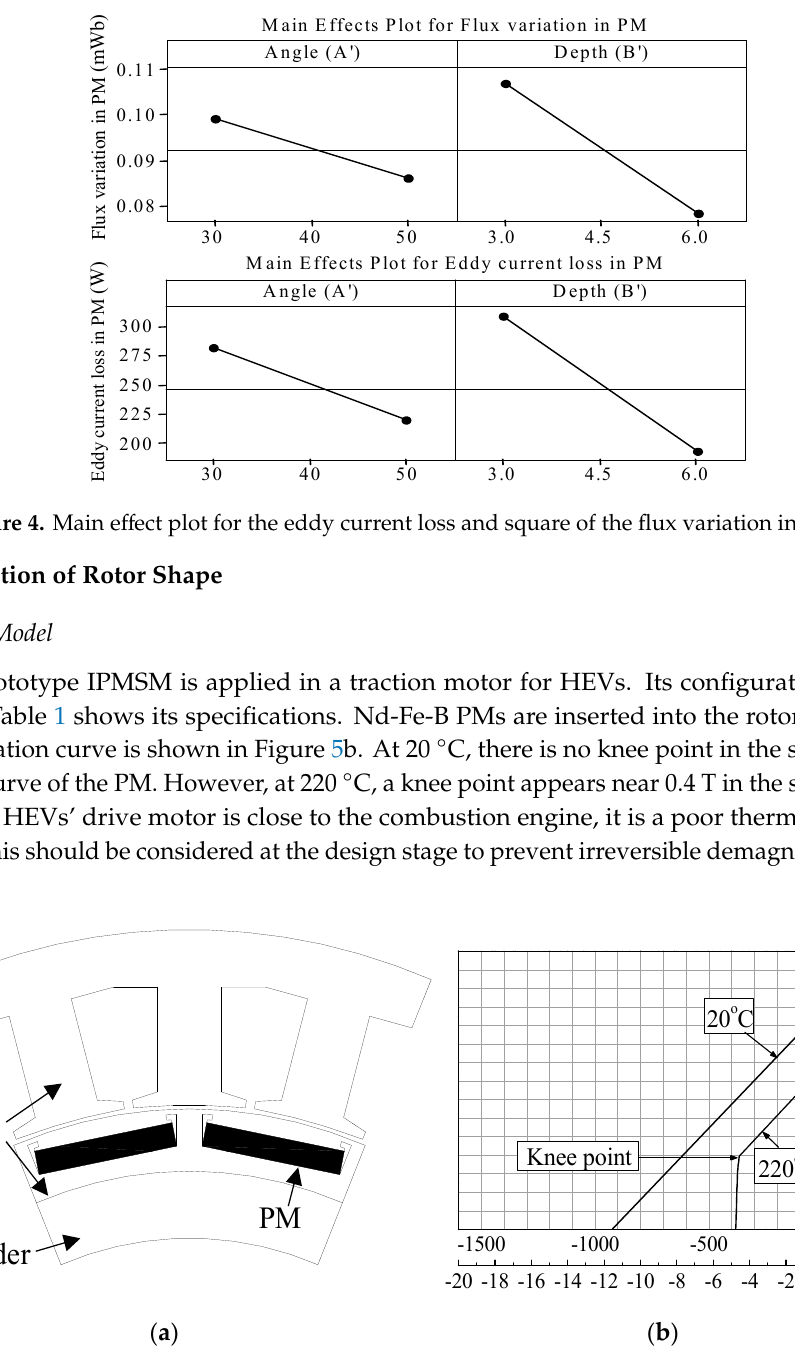
Figure 5. Configuration of design model. ( a ) Configuration of prototype; ( b ) demagnetization curve of Nd-Fe-B PM.